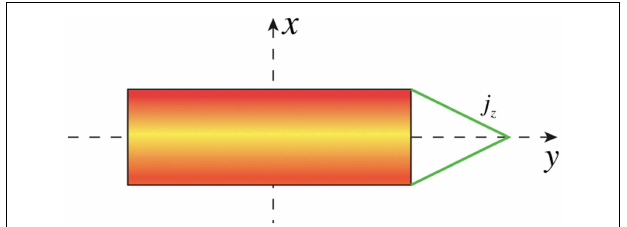
FIGURE 1 | Sketch of the initial configuration of the